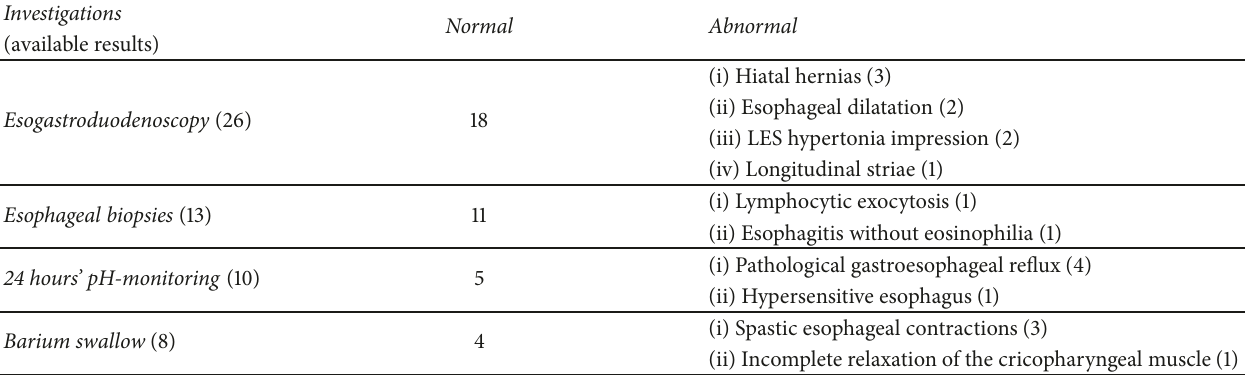
Table 4: Complementary investigations in the patients with Jackhammer